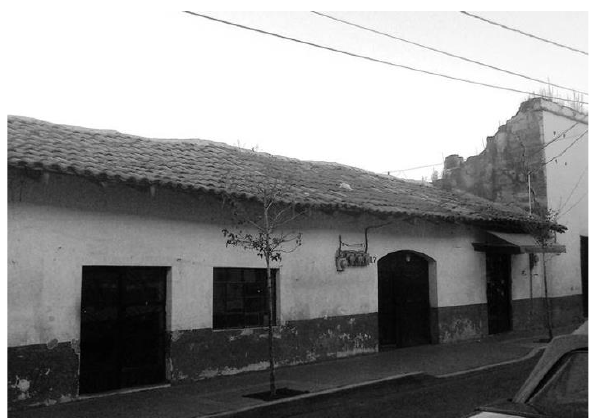
Figure 4. Vernacular architecture in the surrounding streets.